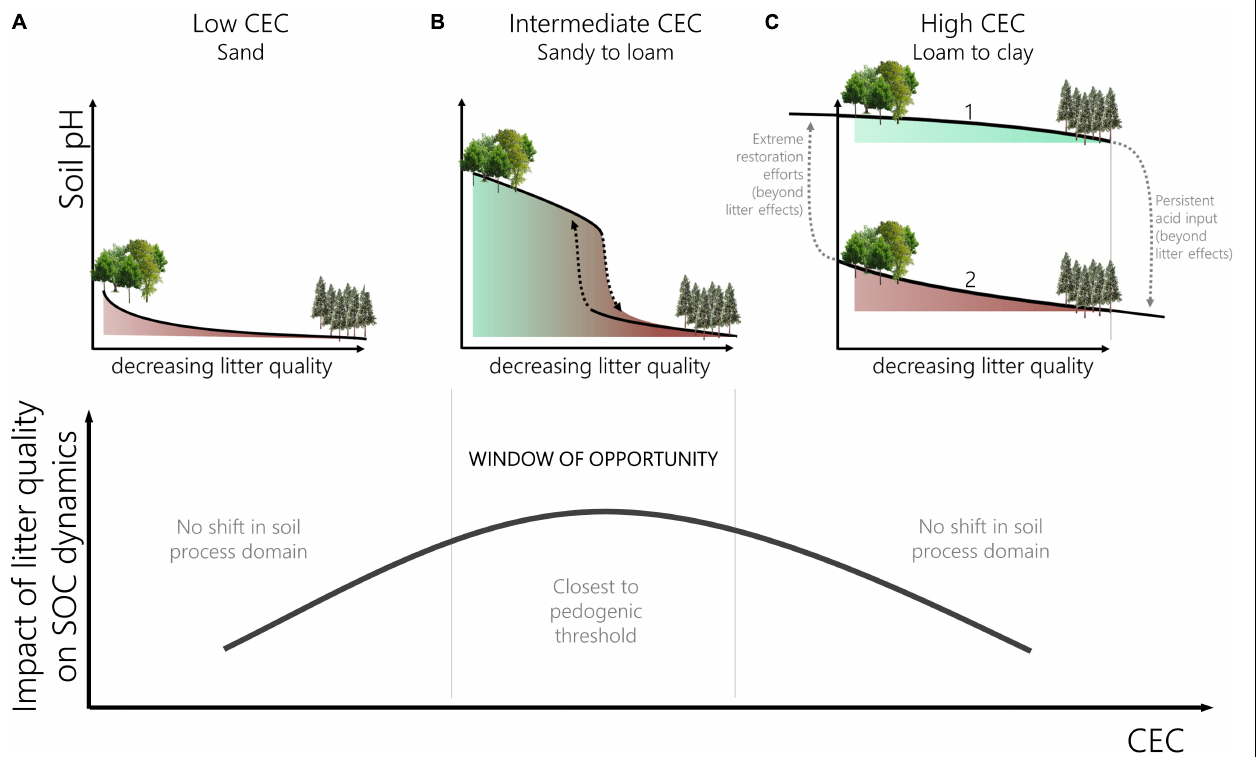
Frontiers in Forests and Global Change |